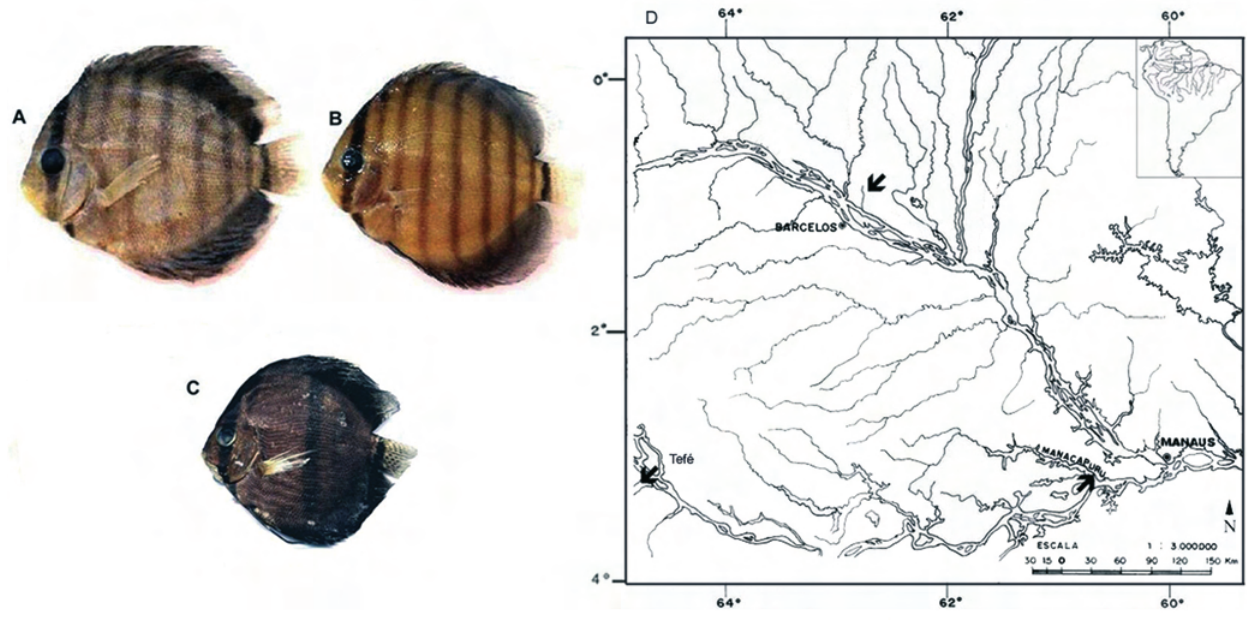
Fig. 1. Photo of analyzed species: (A) Symphysodon haraldi from Manacapuru, (B) S. aequifasciatus from Tefé, (C) S. discus from Barcelos, and map showing the location of discus sampling